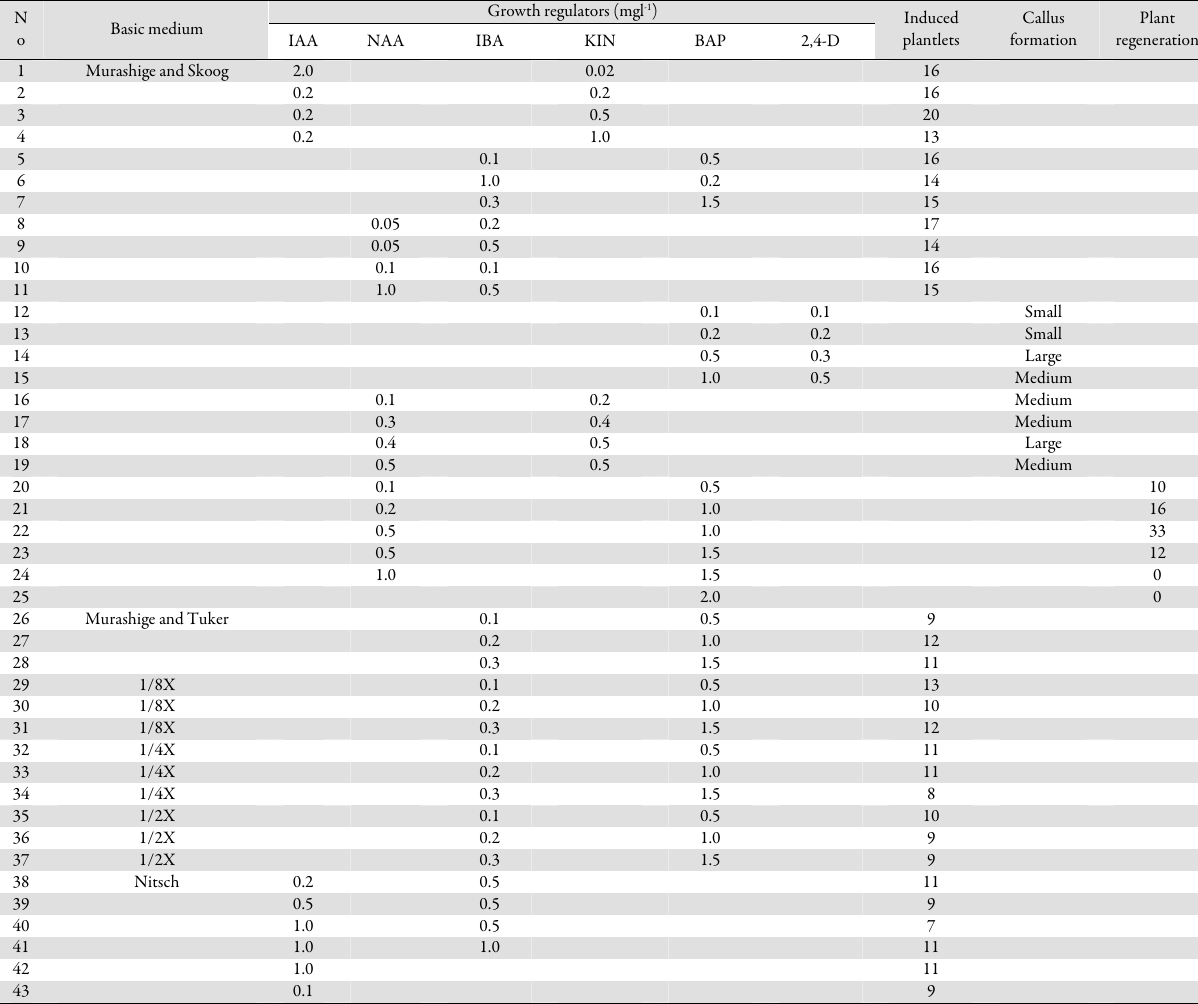
Table 1. Composition of culture